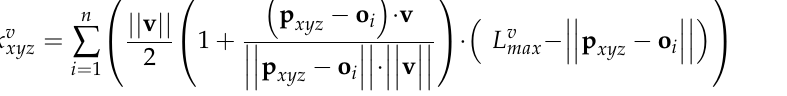
Figure 1. Color coding of space classification importance index ranking from unimportant (white) to very important